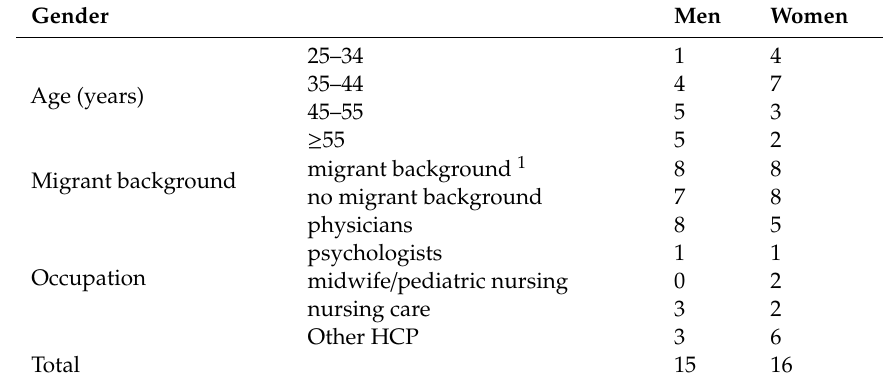
Table 1. Main characteristics of the health care professionals (HCPs) participating in the focus group discussions (FGD) ( n =